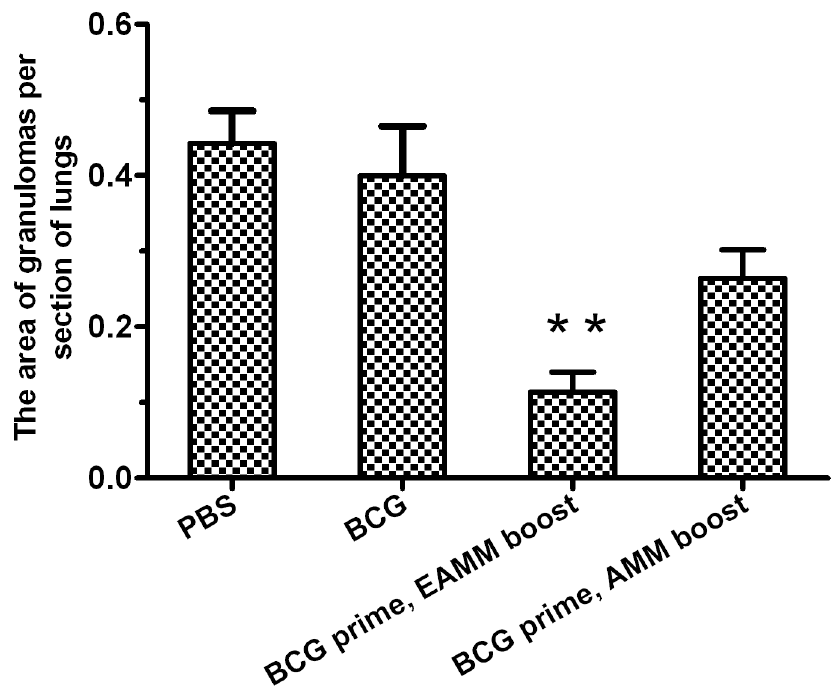
Figure 7. Histopathology induced by vaccine immunization and M. tuberculosis challenge. After infection, the upper left lobes of the lungs were harvested, fixed in 10% formalin and embedded in paraffin blocks, and then sectioned for light microscopy. Data represents the area ratio of granuloma in sections stained with HE. Seven sections of lungs were selected for each group. * p < 0.05 vs. PBS, BCG and AMM group.